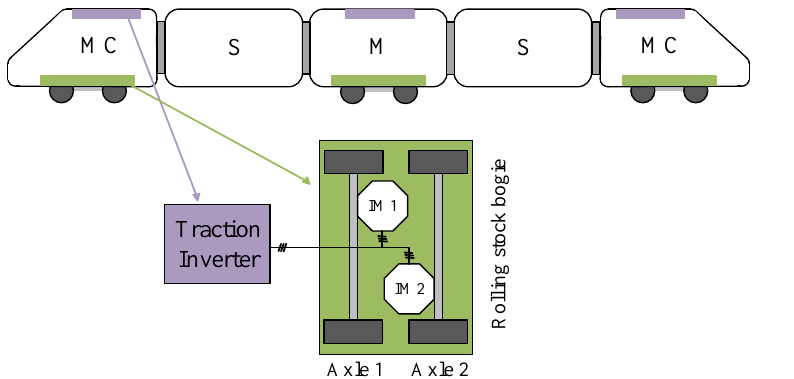
Figure 1. Schematic of the two induction motors in parallel structure from a railway